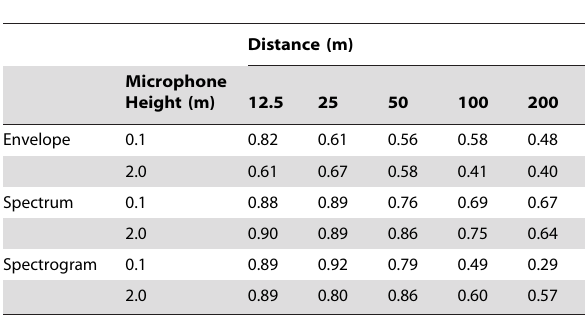
Table 2. Propagation